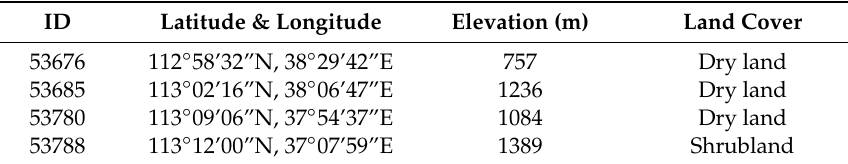
Table 1. Attributes of the stations with SM